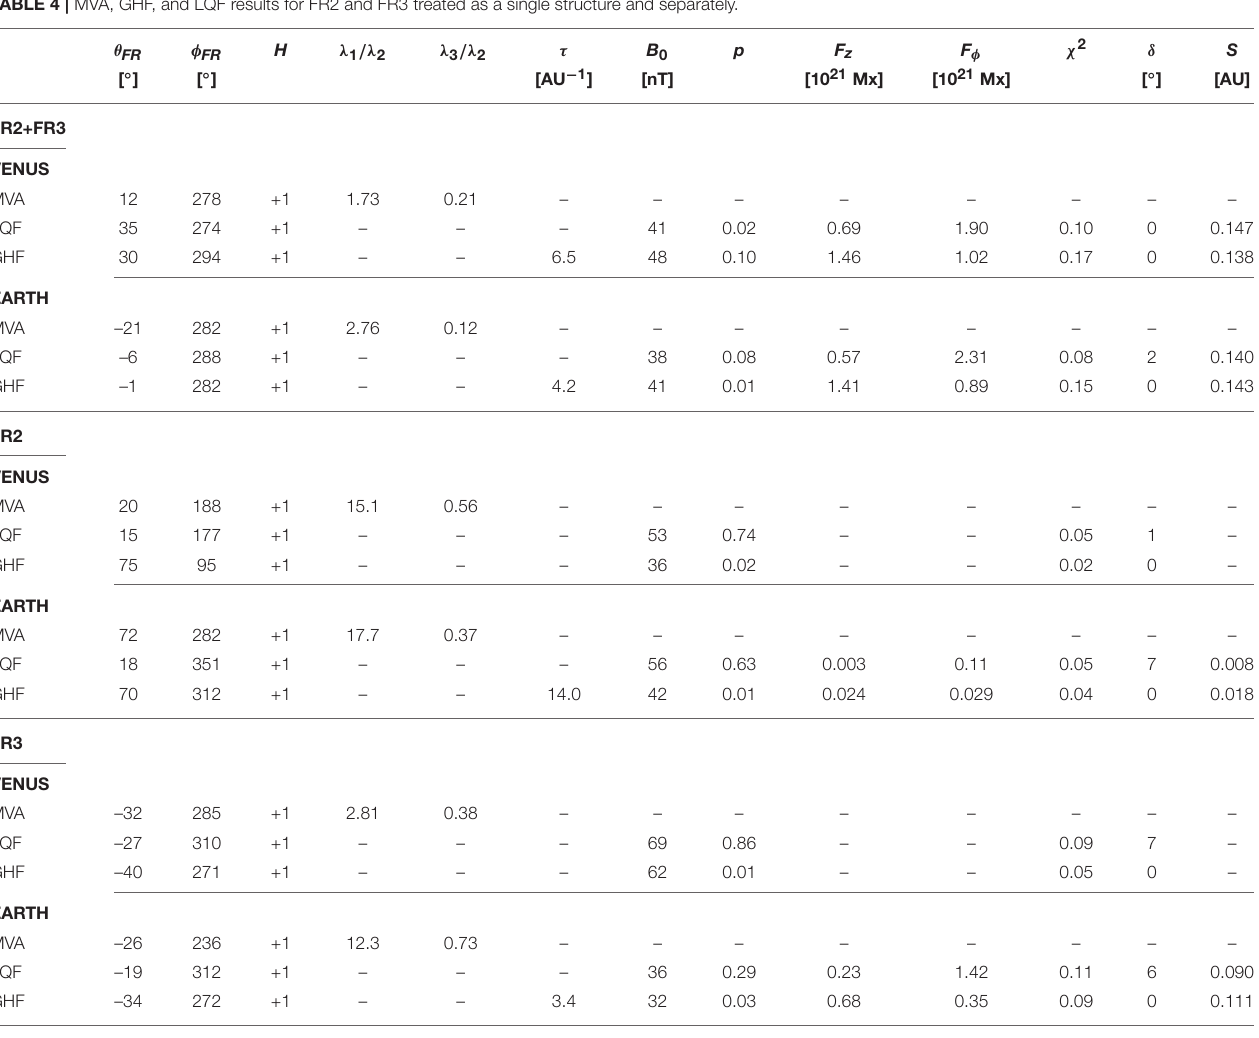
TABLE 4 | MVA, GHF, and LQF results for FR2 and FR3 treated as a single structure and